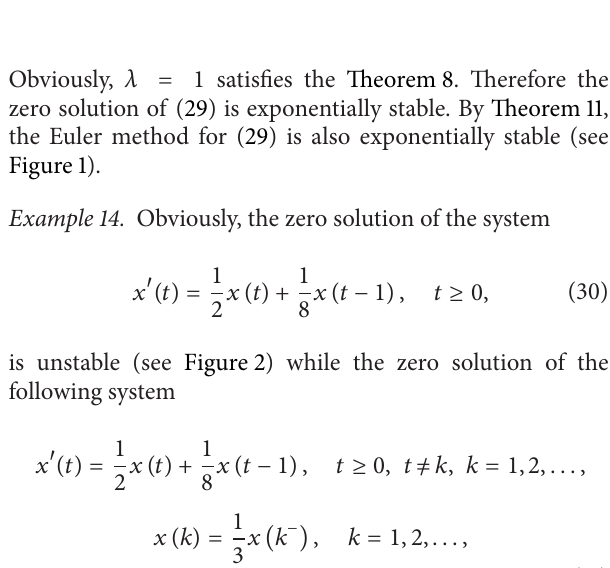
Figure 3: The solutions of (31), as Φ ≡ 1 , ℎ = 1/10